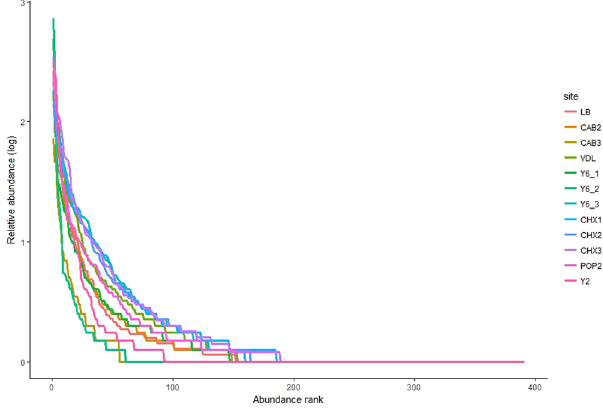
Figure 3. Rank-abundance